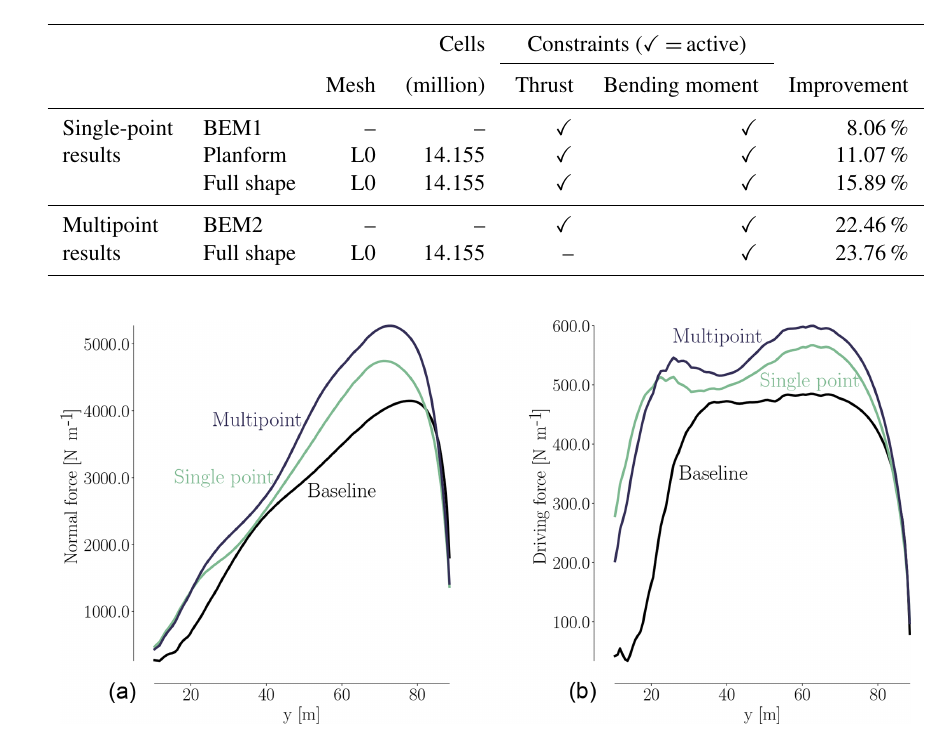
Table 9. Overview of optimization results. As further detailed in Sect. 5.1, the single-point and multipoint optimizations use the operational conditions for the 8ms − 1 case and 5, 8, and 11ms − 1 cases, respectively. Operational conditions are listed in Table A1.